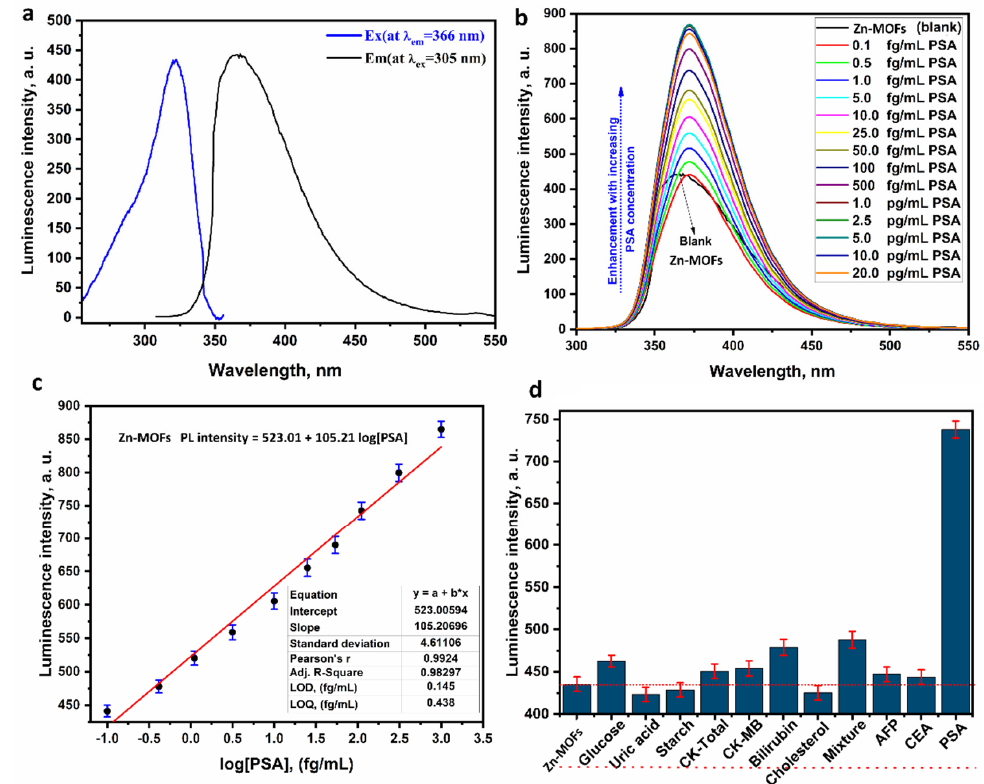
Figure 4. ( a ) The emission and excitation spectra (black and blue lines, respectively) of Zn-M Ο Fs- NP, ( b ) the PL behavior of the Zn-M Ο Fs-NP regarding various PSA concentrations, ( c ) a calibration ( b ) the PL behavior of the Zn-MOFs-NP regarding various PSA concentrations, ( c ) a calibration graph graph between the PL intensities of the Zn-M Ο Fs-NP and the logarithm of the PSA concentrations, between the PL intensities of the Zn-MOFs-NP and the logarithm of the PSA concentrations, and and ( d ) a histogram of the PL intensities of the Zn-M Ο Fs-NP regarding the PSA in the presence of ( d ) a histogram of the PL intensities of the Zn-MOFs-NP regarding the PSA in the presence of some some interfering analytes. interfering